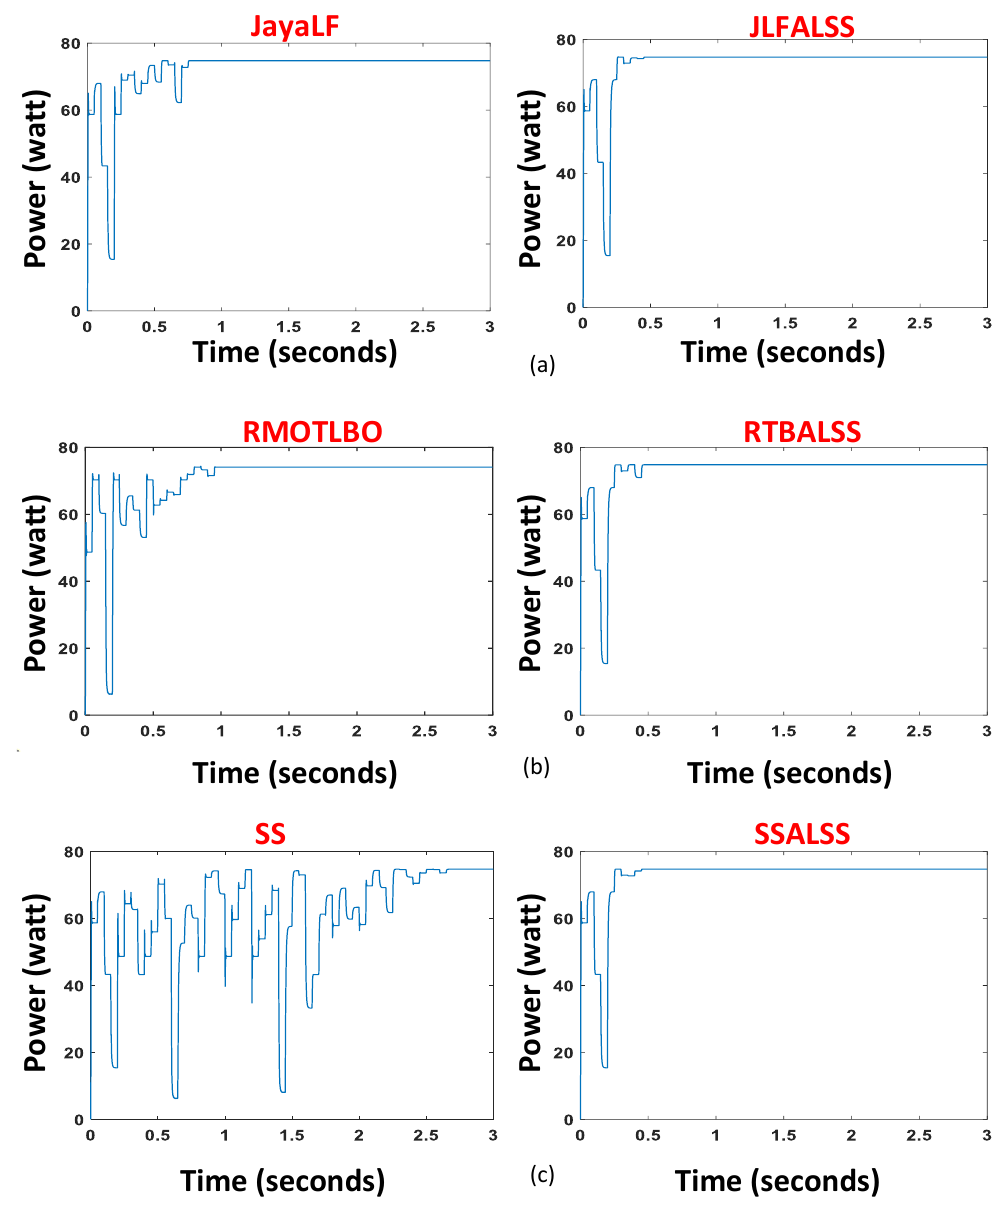
Figure 7. Comparison between ( a ) JayaLF and JLFALSS, ( b ) RMOTLBO and RTBALSS, and ( c ) SS and SSALSS for